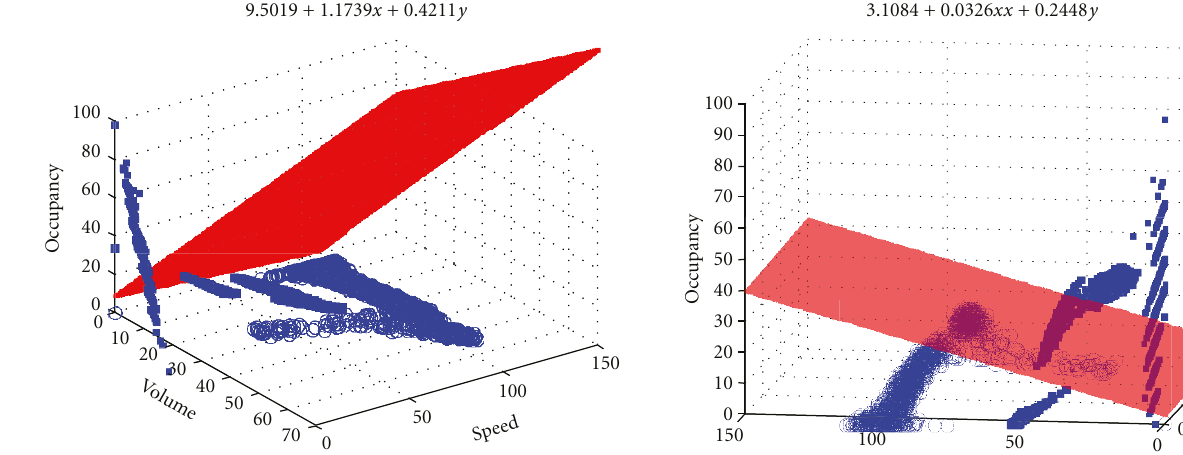
(a) Congested-Dense (CD-SVM). In the training, CD-SVM target “+1” indicates that data belongs to Class 1 (i.e., congested tra ffi c). The other alternative of “ − 1” indicates that the data belongs to Class 2 (i.e., dense tra ffi c).